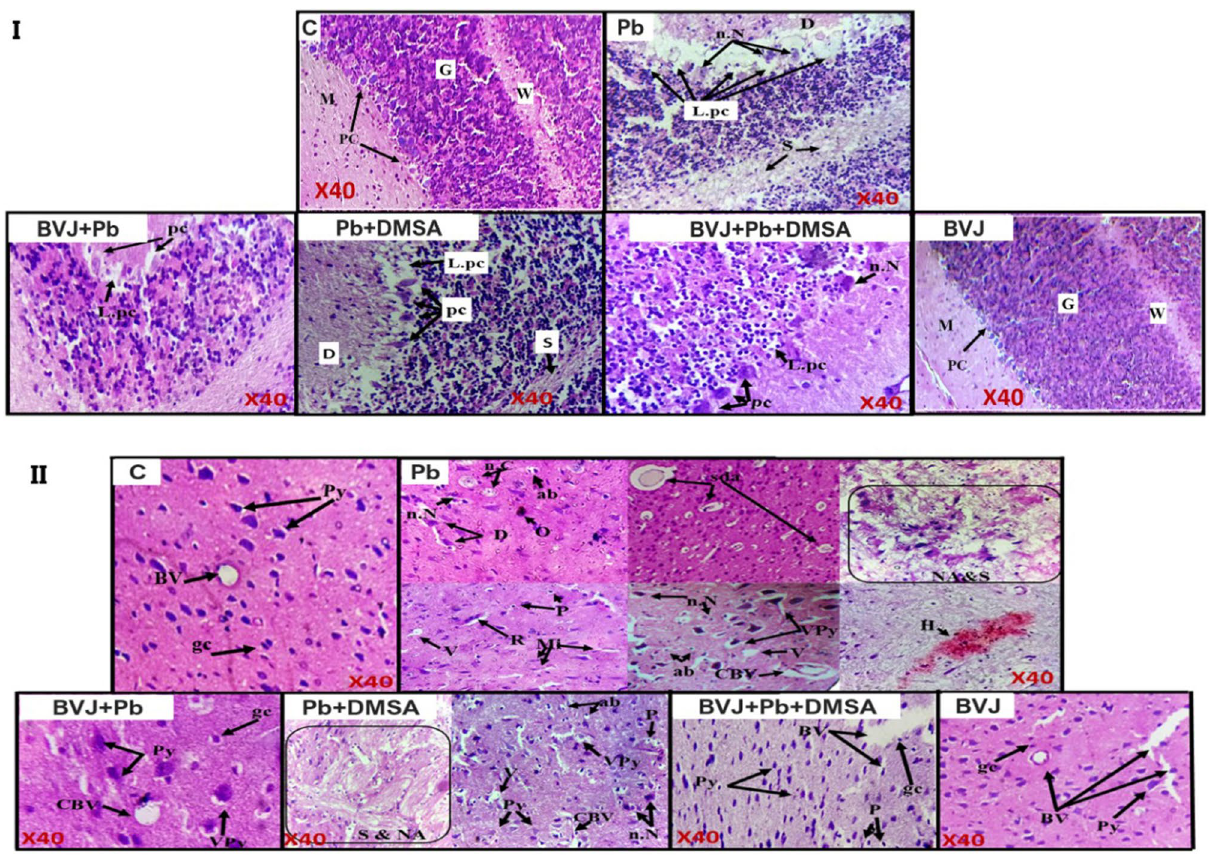
Figure 5. Representative photomicrographs of the cerebellum and the cerebral cortex in the brain of control (C) and Pb-intoxicated rats with and without administration of Beta vulgaris juice (BVJ), dimercaptosuccinic acid (DMSA), or their combination (BVJ + DMSA). Where ( I ): photomicrographs of the cerebellum, and ( II ): photomicrographs of the cerebral cortex. ab apoptotic bodies, BV blood vessel, CBV congested blood vessel, D degeneration, G glial layer, gc glial cells, H hemorrhage, L.pc loss of Purkinje cells, M molecular layer, Mi microgliosis, NA necrotic area, n. C neuronal chromatolysis, pc Purkinje cells, W white matter layer, n.N neuronal necrosis, O osseous metaplasia, P pyknosis, Py pyramidal cells, R reactive gliosis, S spongiosis, sda swollen degenerate axons, V vacuolization, VPy vacuolized pyramidal cells, × 40 magnification of the